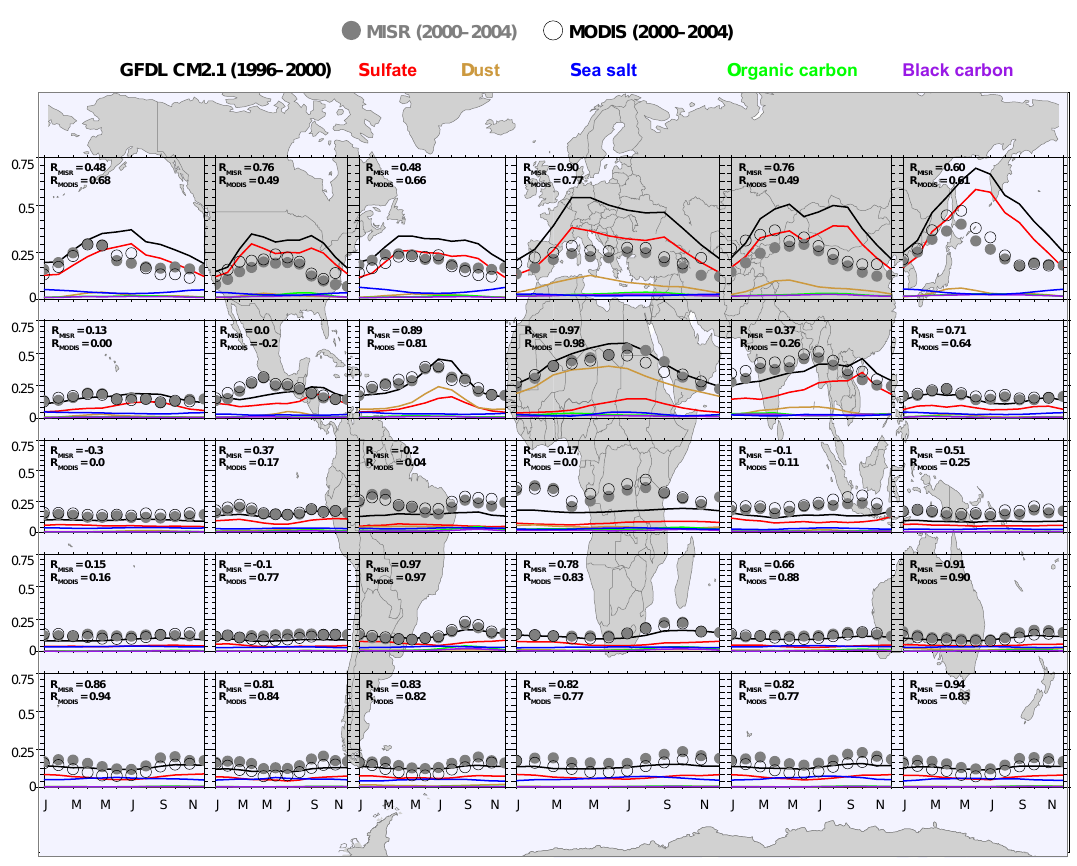
Figure 4. Regional observed and model-derived monthly aerosol optical depth at 550nm. Total CM2.1 AOD (black lines) and individual AODs (sulfate: red, organic carbon: green, black carbon: violet, sea salt: blue, dust: brown) are shown as well. Values are surface-weighted averages within each panel. Correlations between observed and total simulated AODs are